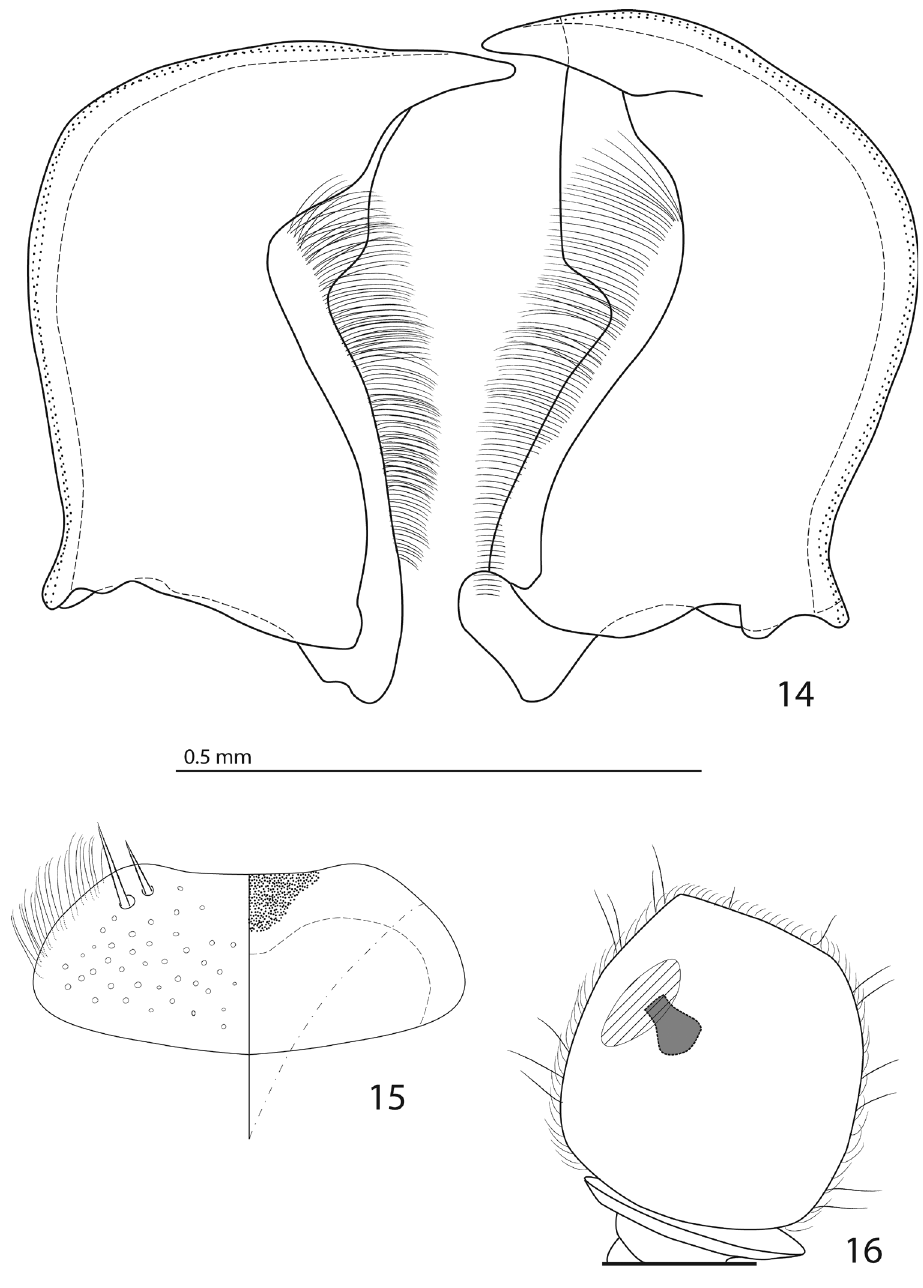
left half depicting dorsal view and right half depicting epipharynx 16 antennal club depicting sensory struc- tures of the